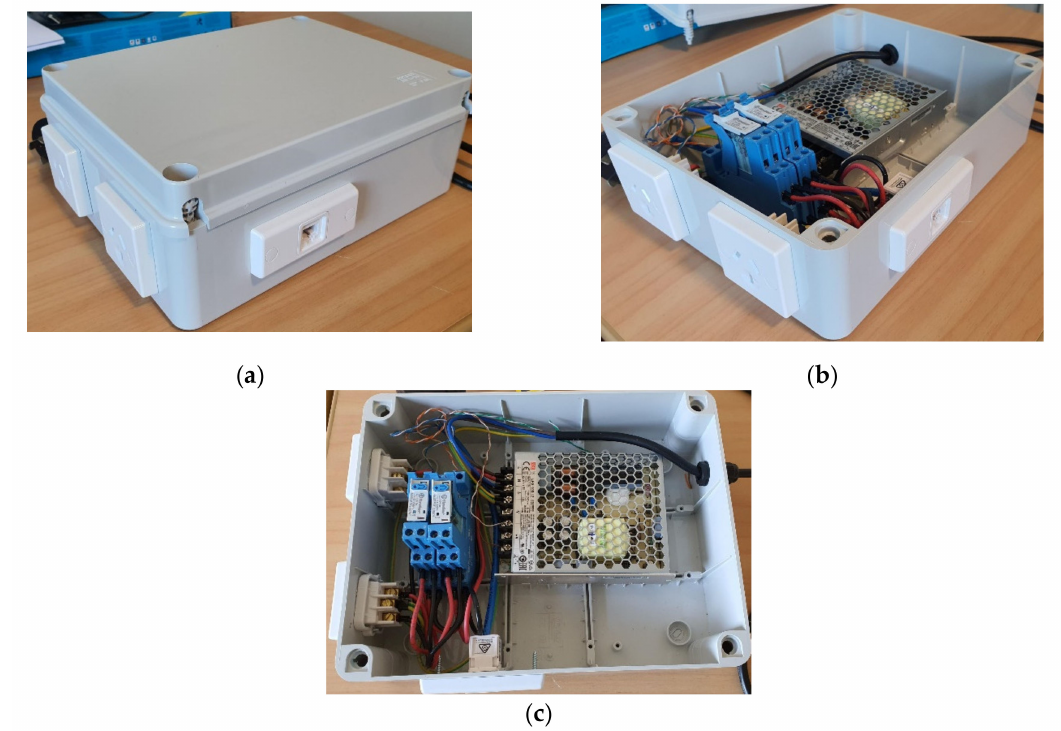
Figure 19. Power supply box layout. ( a ) Sealed box with 230 V AC and 24 V DC outputs; ( b ) Box with cover removed; ( c ) Plan view of open box showing relay connections and 24 V DC supply